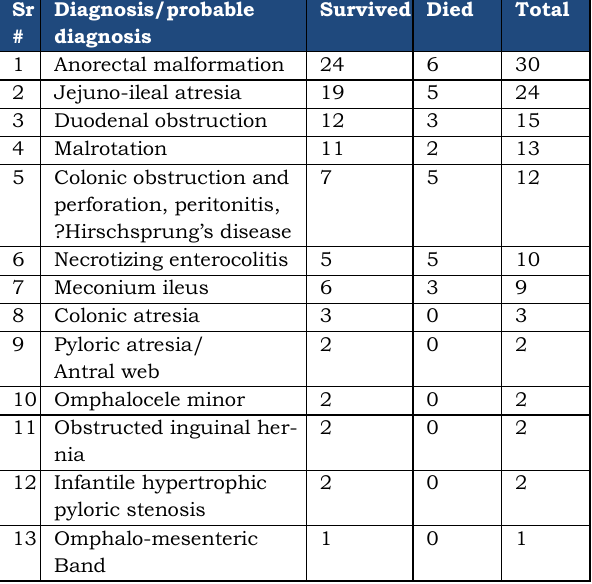
Table 4: Diagnosis (cause of NIO) of patients in our series (n=120)